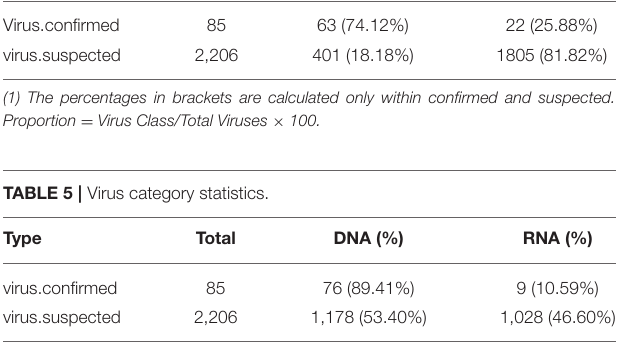
Frontiers in Veterinary Science |